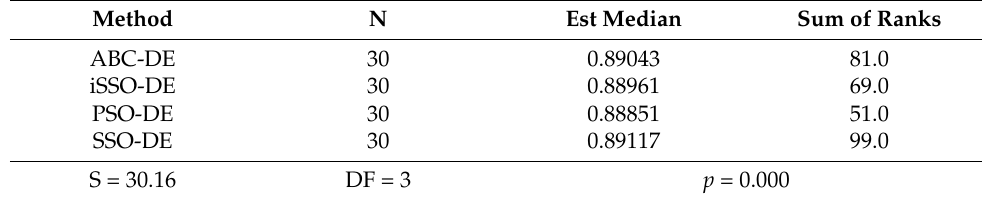
Table 24. Experiment results of Friedman’s test.